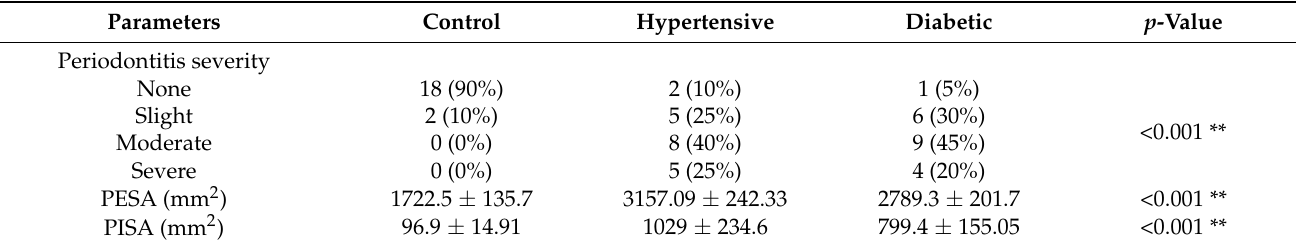
Table 4. Severity of periodontitis based on CDC/AAP classification, PESA, and PISA